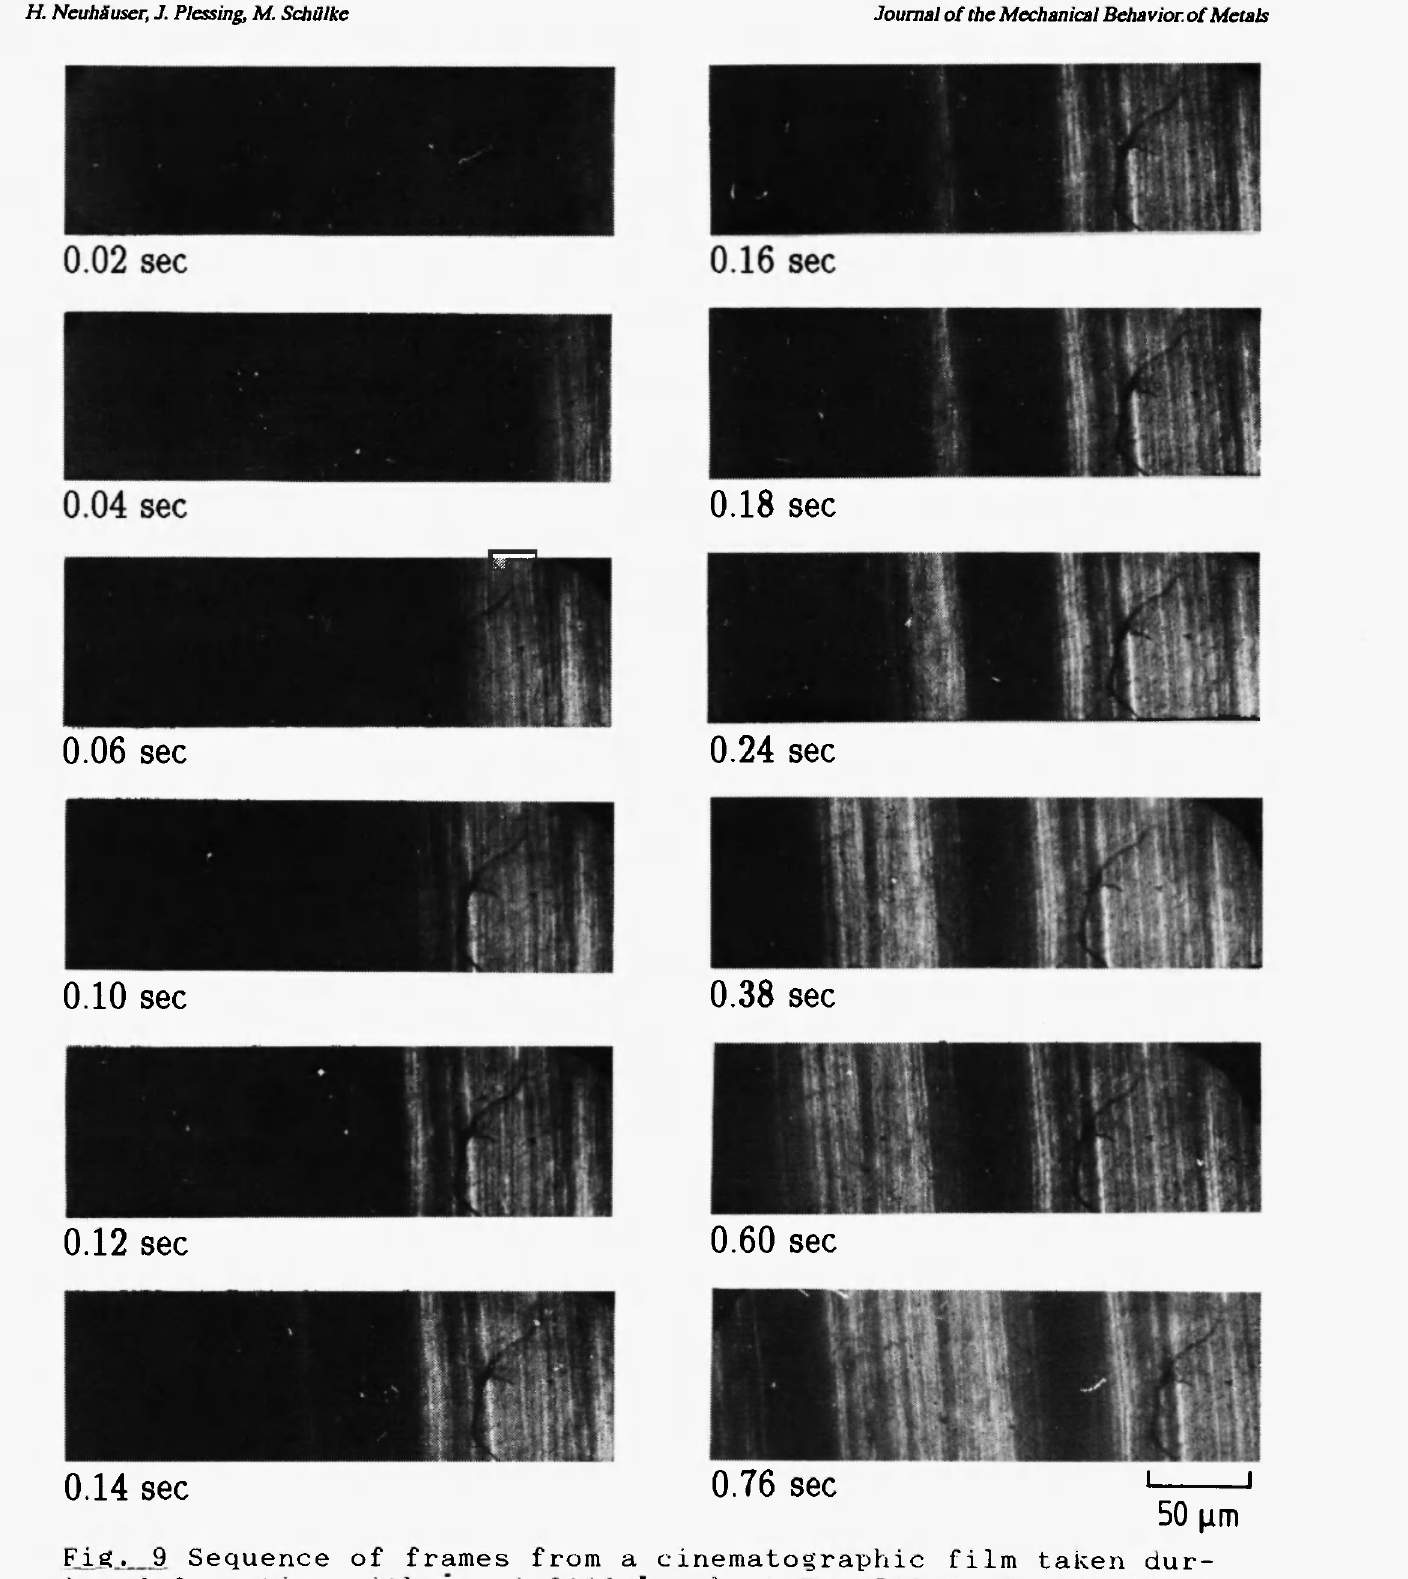
Fig. 9 Sequence of frames from a cinematographic film taken dur- ing deformation with € = 1.8*10" 5 s" 1 at Τ = 500 Κ of a Cu-10at% Al crystal showing' the rapid growth ( in particular during the first part of the sequence) of a slip band bundle by adding new slip bands at its